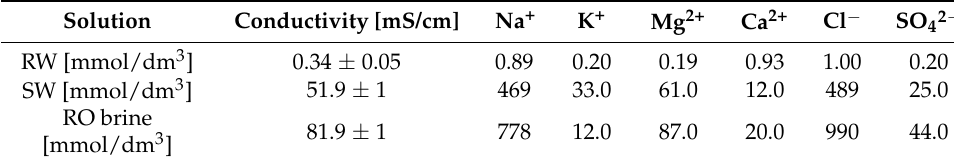
Figure 1. Water desalination plant of Okinawa islands in Chatan town, Japan [33]. Table 1. Ion composition of available solutions in the water desalination